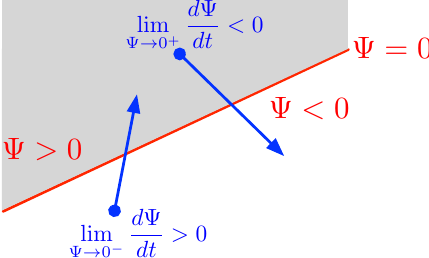
Figure 6. Concept of reachability